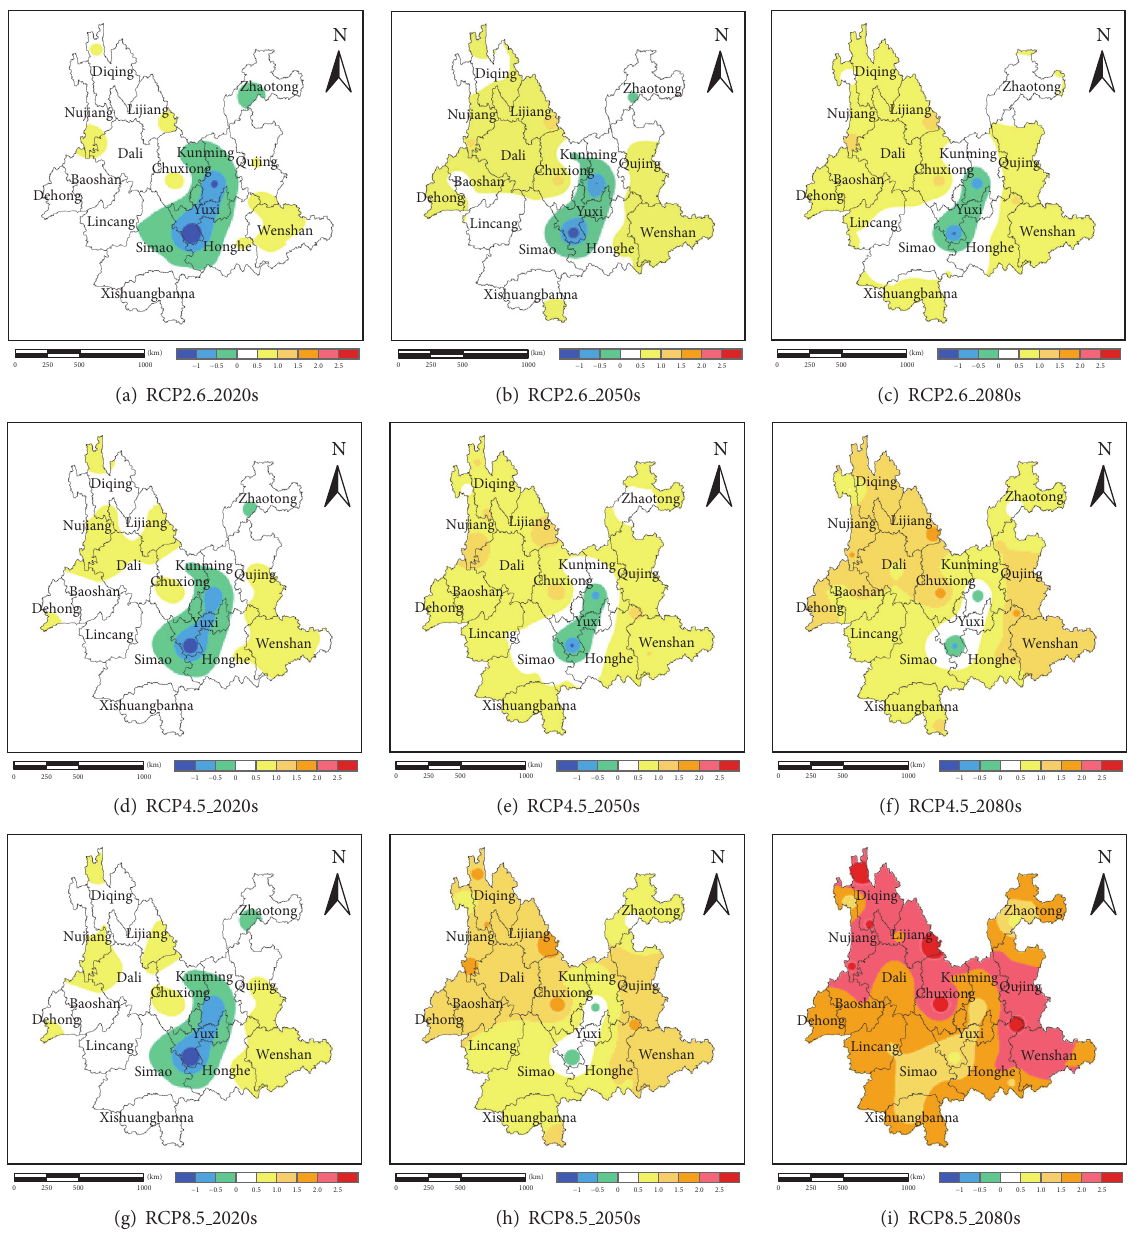
Figure 8: Spatial distribution of the increase in annual mean temperature in Yunnan province under three scenarios.